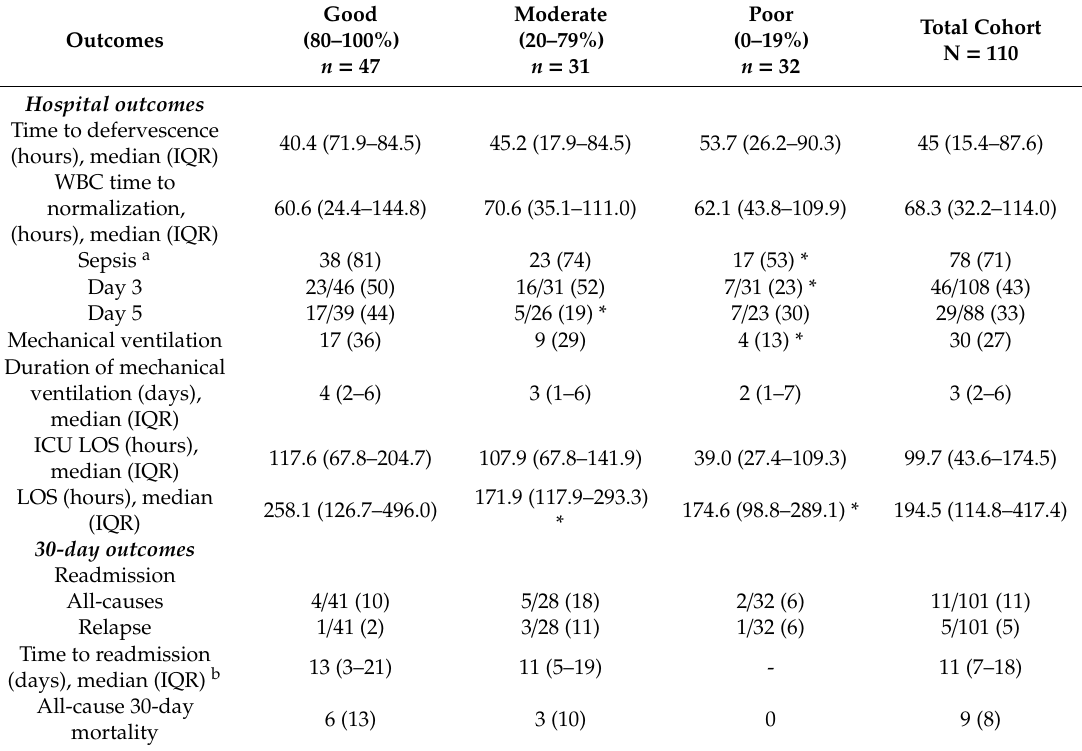
Table 3. Clinical outcomes stratified by the level of